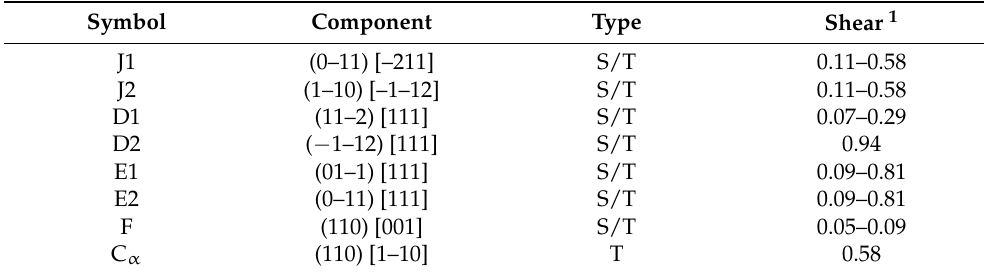
Figure 1. Observed symmetry-breakdown-related fracture in steel. ( a ) Inverse pole figure (IPF) coloring of fractured lath- shaped microstructure in 42CrMo4 steel austempered below M S . Colors of crystals agree with the orientations perpendicular to the observed plane, which is indicated in the stereographic triangle; ( b – e ) Pole figures of an orientation distribution function (ODF) rotated to represent the symmetry about the (111) pole: ( b ) Ideal 6-fold symmetry, ( c ) evident 6-fold symmetry in Area I, ( d ) strongly deformed 6-fold symmetry in Area II, and ( e ) 6-fold symmetry is undetectable in cracked Area III. Table 2. Description of observed b.c.c. texture components developed either directly by shear (S) or by the transformation of sheared austenite